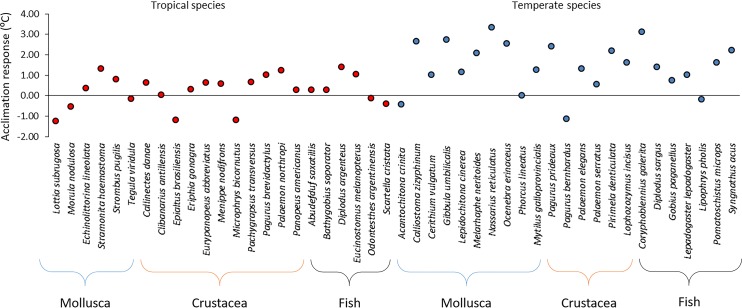
Acclimation response (CTMax10 days—CTMaxcontrol) of tropical (in red) and temperate (in blue) coastal species (values different from zero have a p<0.05).